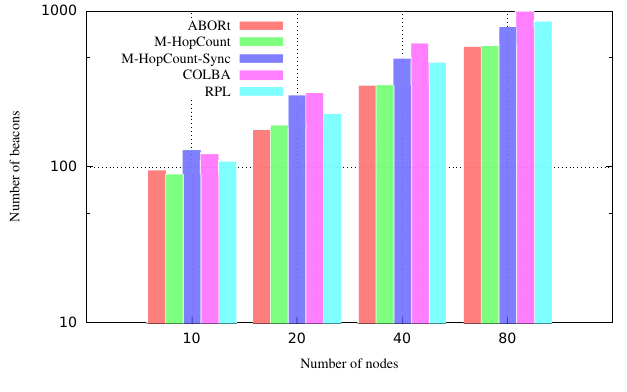
Figure 12. Overhead for 5 pkts/s/node.